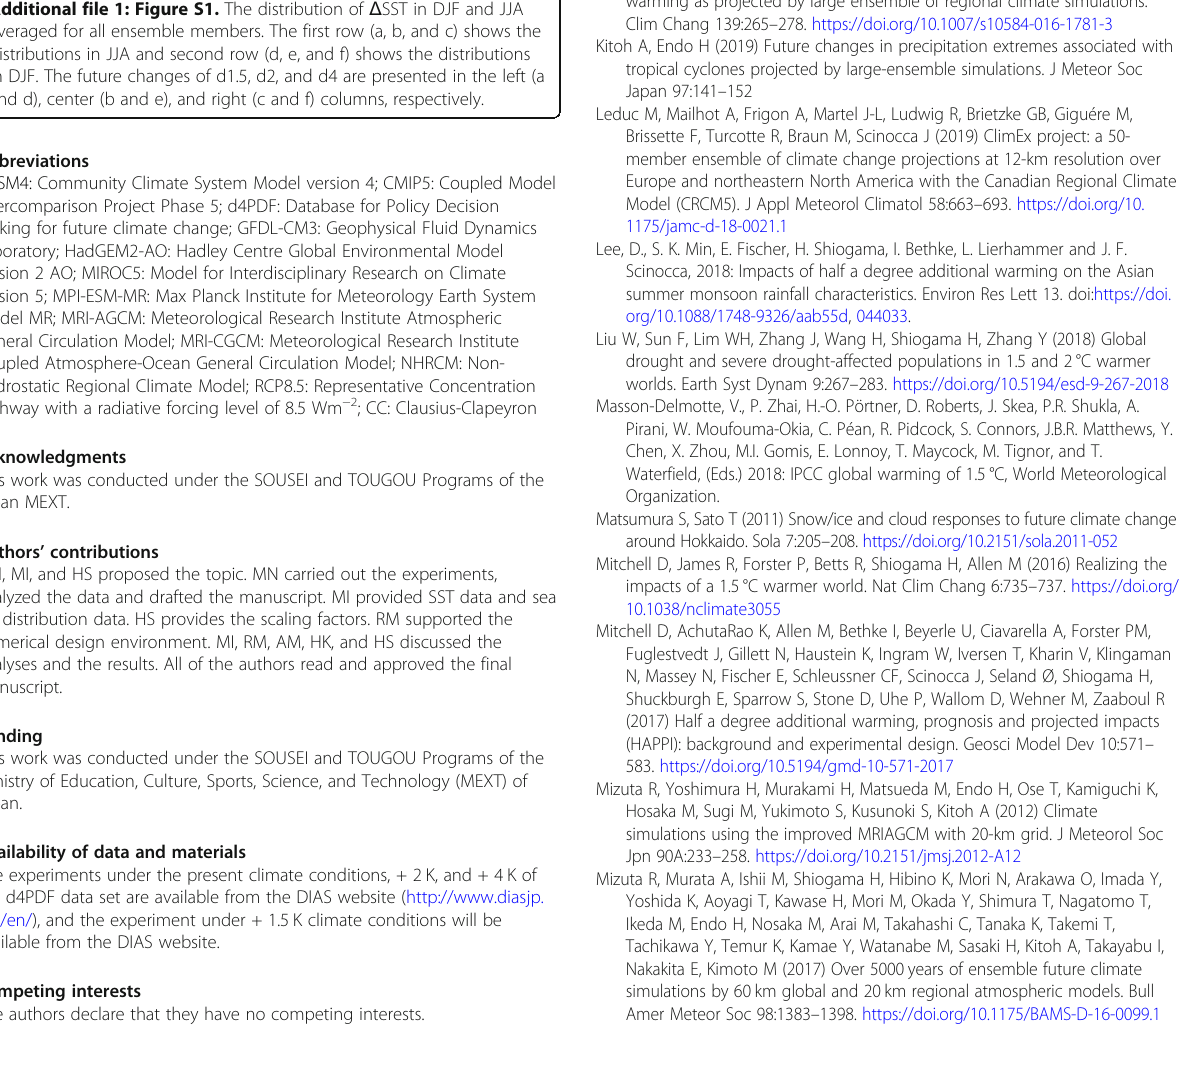
Additional file 1: Figure S1. The distribution of Δ SST in DJF and JJA averaged for all ensemble members. The first row (a, b, and c) shows the distributions in JJA and second row (d, e, and f) shows the distributions in DJF. The future changes of d1.5, d2, and d4 are presented in the left (a and d), center (b and e), and right (c and f) columns,